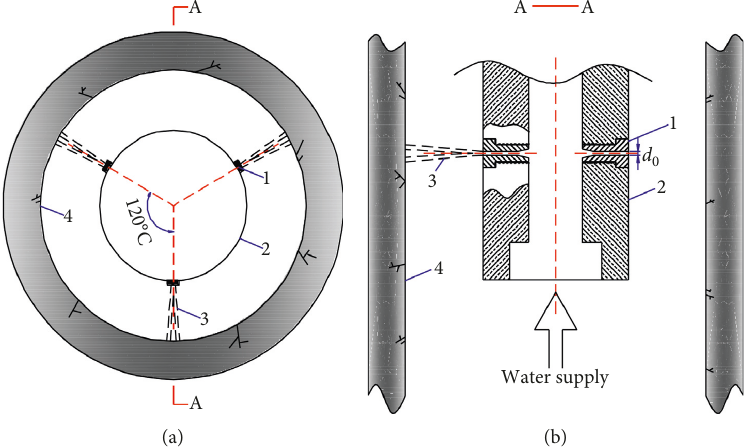
Figure 11: The schematic diagrams of rotary cutting process by pressurized water jet. (a) The vertical view; (b) the front view. Note: 1, jet nozzle; 2, drill; 3, pressurized water jet; 4, initial borehole wall.